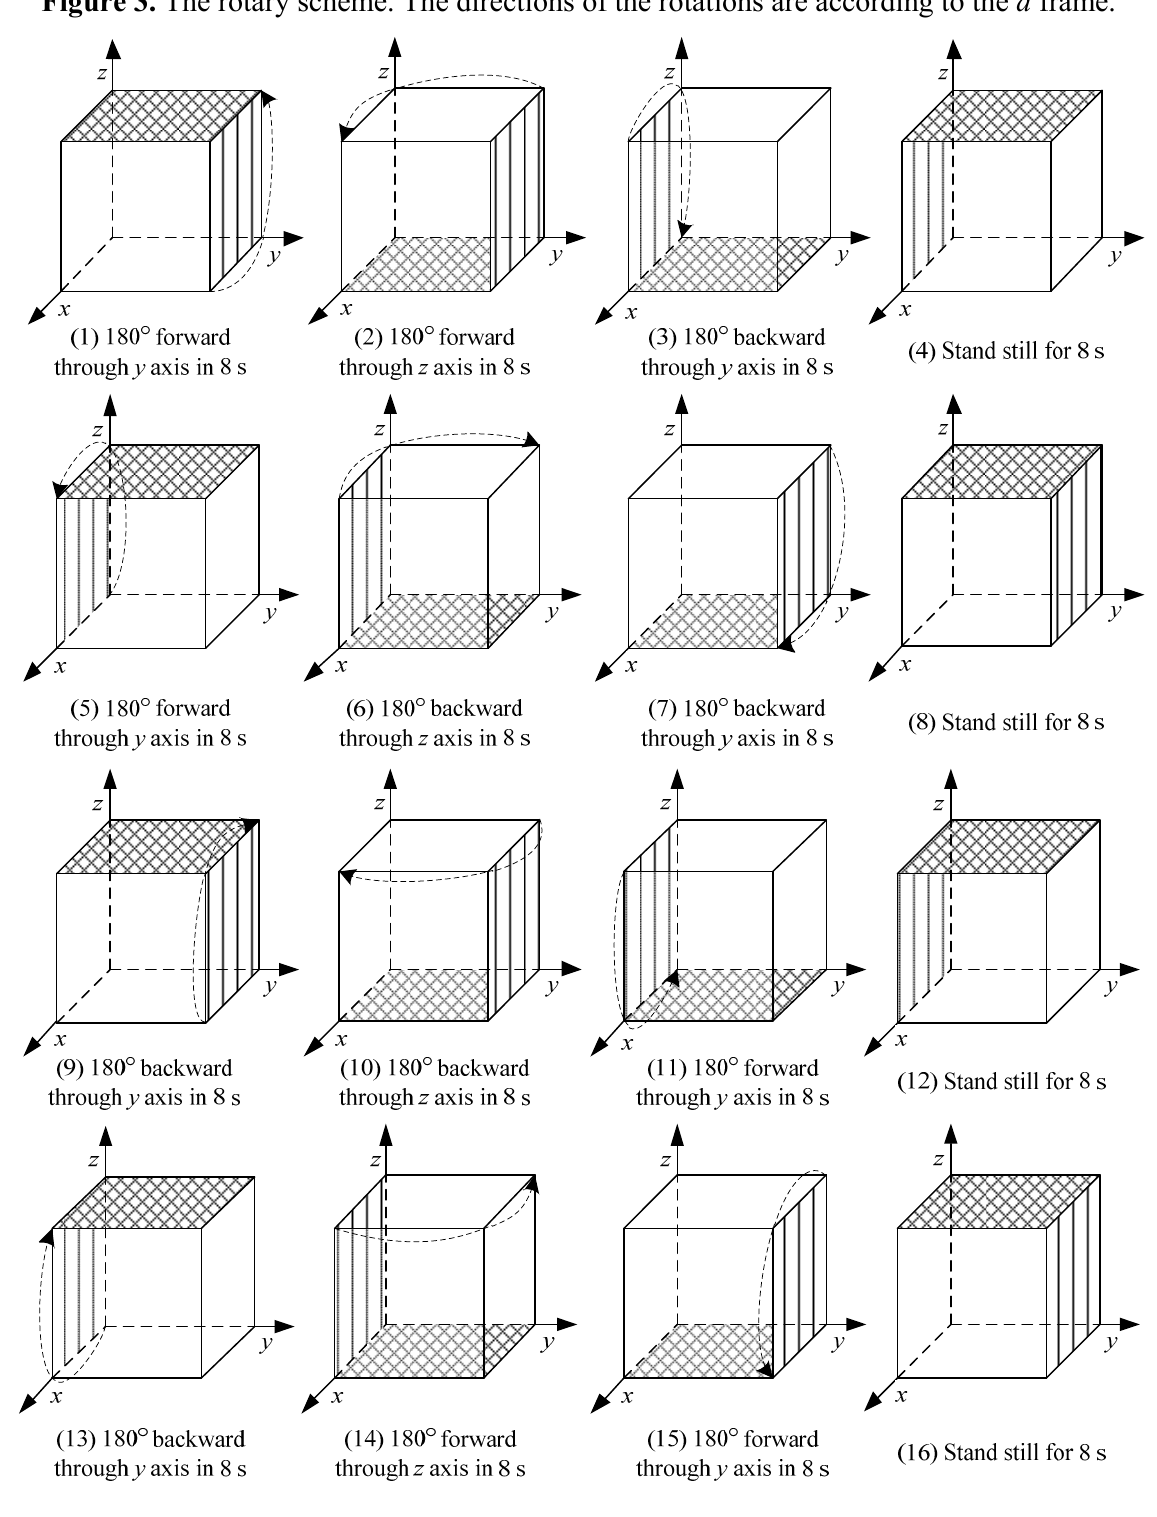
Figure 3. The rotary scheme. The directions of the rotations are according to the d